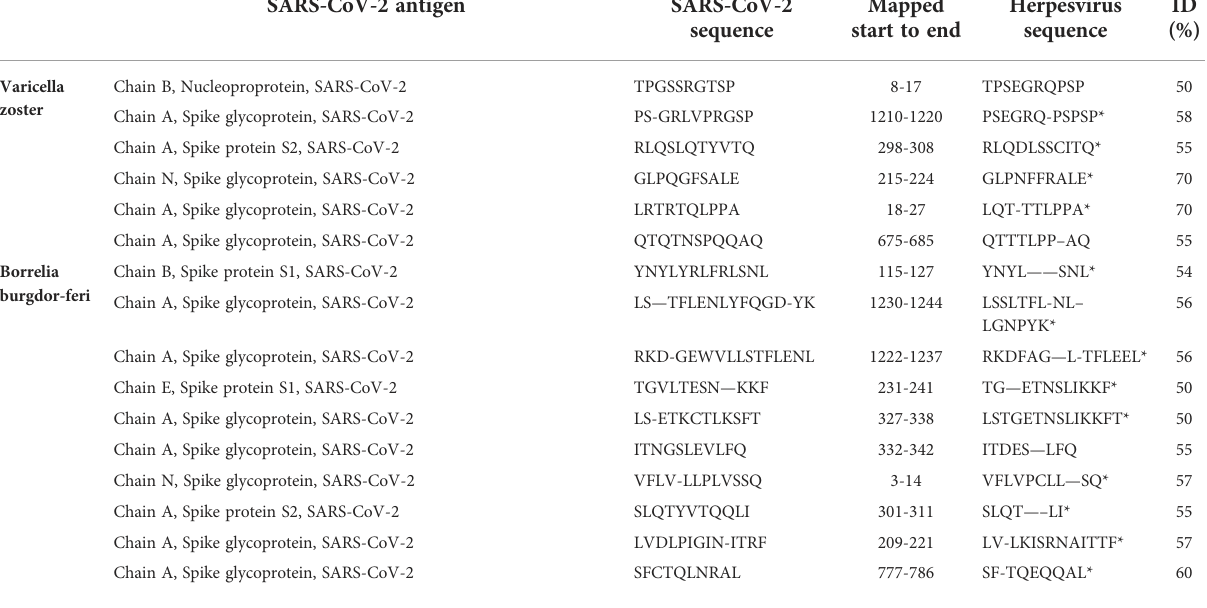
(Figure 1). While the reaction of SARS-CoV-2 nucleoprotein monoclonal antibody with DTaP vaccine was the strongest, the overall reaction of anti-nucleoprotein antibody with the vaccines, viral and bacterial antigens was less strong (Figure 2). These results further con fi rm the fi ndings of Reche (15), that the combination of DTaP vaccines are signi fi cant sources of T and B cell cross-reactivity to SARS-CoV-2, and cross-reactive immunity to DTaP vaccines can be protective against